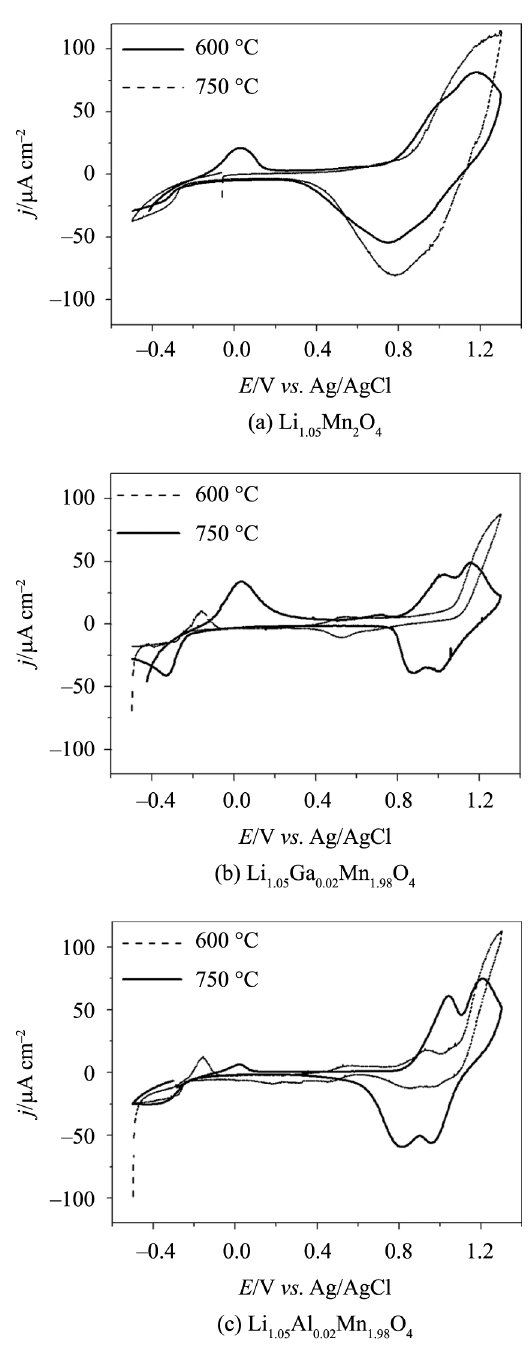
Figure 3. XRD patterns of the: (a) Li Mn O ; 1.05 2 4 and (c)